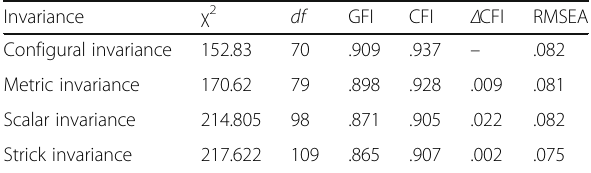
Table 1 Fit indices for measurement invariances